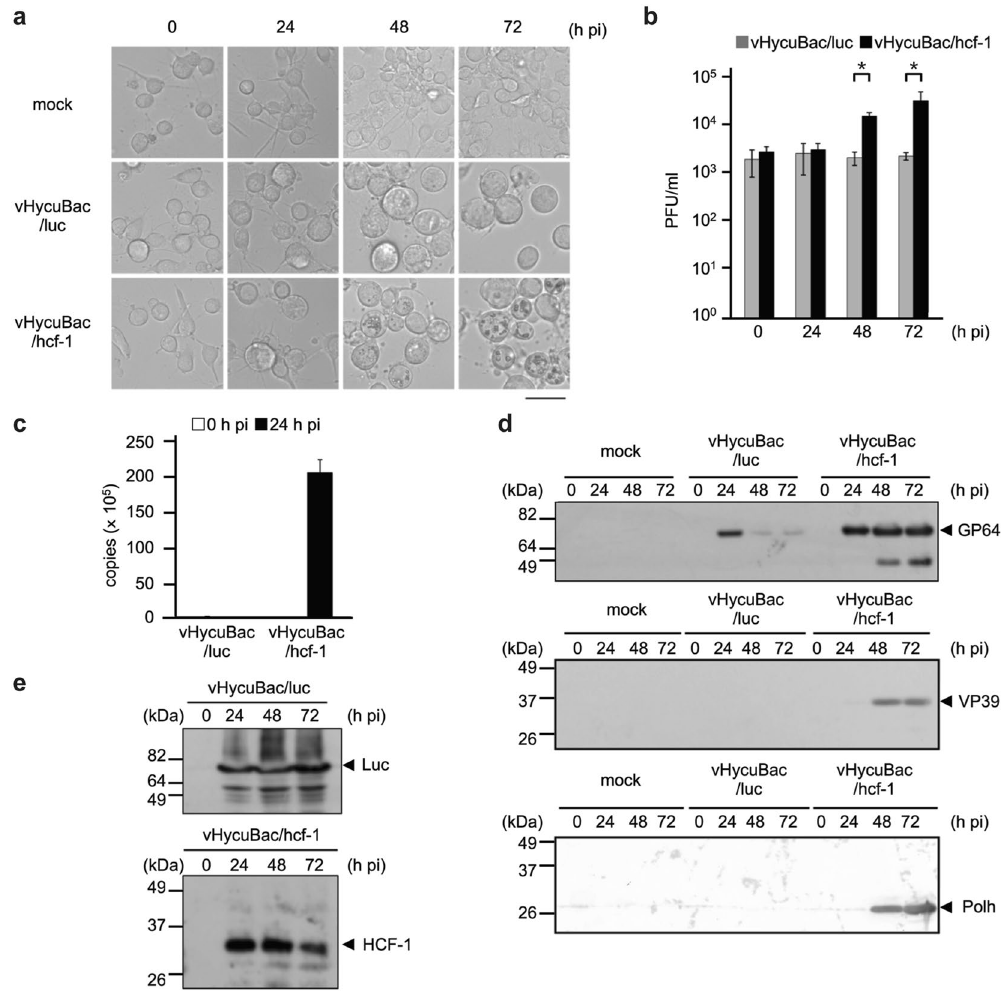
Figure 4. HycuMNPV harboring the hcf-1 gene replicates in non-permissive Tn368 cells. Tn368 cells were infected with vHycuBac, vHycuBac/hcf-1 or vHycuBac/luc at an MOI of 5 and examined at 0, 24, 48 and 72 h post-infection (pi). ( a ) Microscopic images of virus-infected Tn368 cells. mock, Mock-infected Tn368 cells. Scale bar, 50 μ m. ( b ) BV yields in virus-infected Tn368 cells. BV titers were determined by a plaque assay using SpIm cells. The vertical bars represent the standard deviations of the averages from three determinations. Asterisks ( * ) indicate statistical significance (P < 0.05) in a Student t-test comparing vHycuBac/hcf-1 with vHycuBac/luc (P values = 0.0011 (48 h pi) and 0.0399 (72 h pi). ( c ) Viral DNA production in virus-infected Tn368 cells at 24 h post-infection. Viral DNA was quantified by qPCR. The vertical bars represent the standard deviations of the averages from three determinations. ( d ) Immunoblot analysis of GP64, VP39 and polyhedrin (Polh) proteins. mock, Mock-infected Tn368 cells. For details on the detection and visualization of GP64, VP39 and polyhedrin (Polh), see the legend of Fig. 3d. ( e ) Immunoblot analysis of luciferase and HCF-1 proteins in infected Tn368 cells. For details on the detection and visualization of luciferase and HCF-1, see the legend of Fig. 1f. In panels ( d ) and ( e ), polypeptides equivalent to 1 × 10 5 cells were analyzed in each